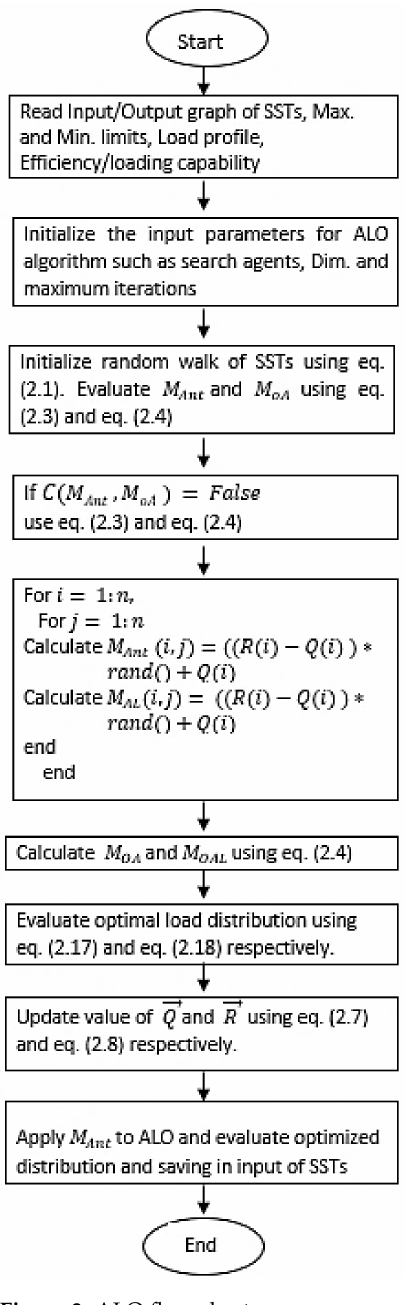
Figure 3. ALO flow